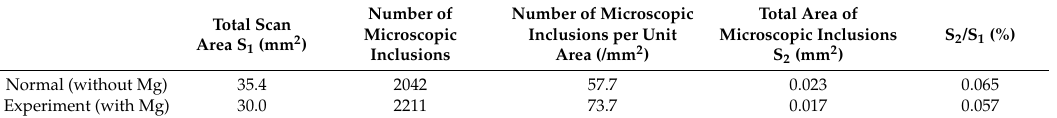
Table 5. Partial test results of automatic scanning system for